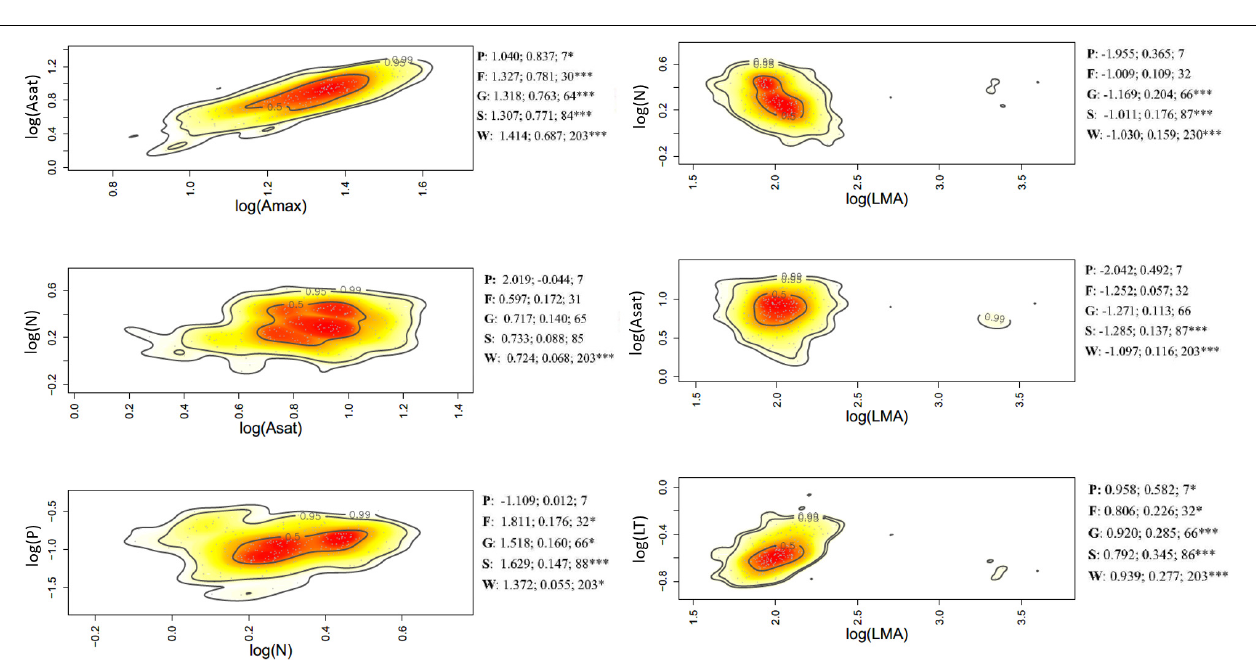
FIGURE 3 | Bivariate trait relationships at the elevation gradient expressed through kernel density plots for selected trait bivariate relationships, and results of SMA regressions (slope, r2, degrees of freedom) for trait values community weighted at the tree level (W), species (S); genus (G); family (F), and plot (P). Stars *** represent significant after Holm correction. Full results of SMA regression analyses for the whole suite of traits are presented in Supplementary Table S4 .